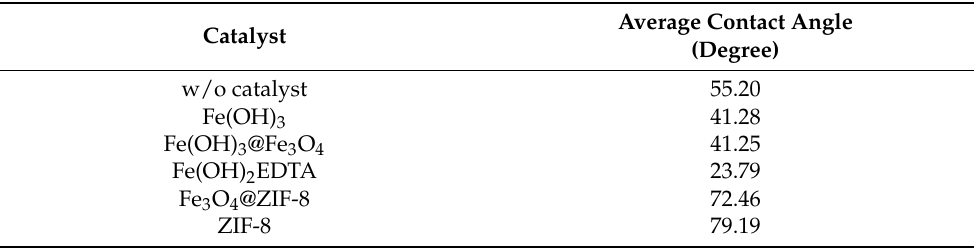
Table 6. Average contact angle values of base membrane (w/o catalyst) and various catalysts coated on base membrane.